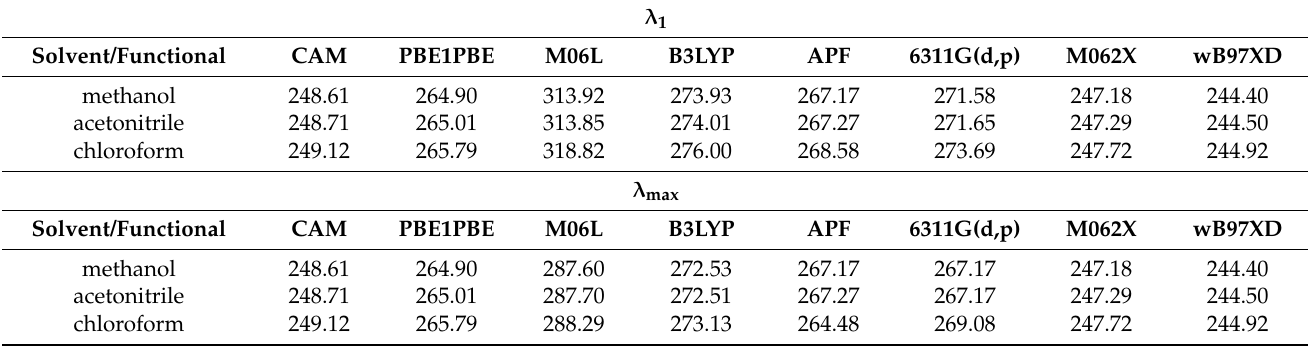
Table 8. Calculated wavelength for first excited state ( λ 1 ) and maximum of absorption ( λ max ) for bifonazole 1 using different functionals: B3LYP —B3LYP/6-31G(d,p); 6311G(d,p) —B3LYP/6- 311++G(d,p); CAM —CAM-B3LYP/6-31G(d,p); APF —APF/6-31G(d,p); M06L —M06L/6-31G(d,p); M062X —M062X/6-31G(d,p), PBE1PBE —PBE1PBE/6-31G(d,p); wB97XD